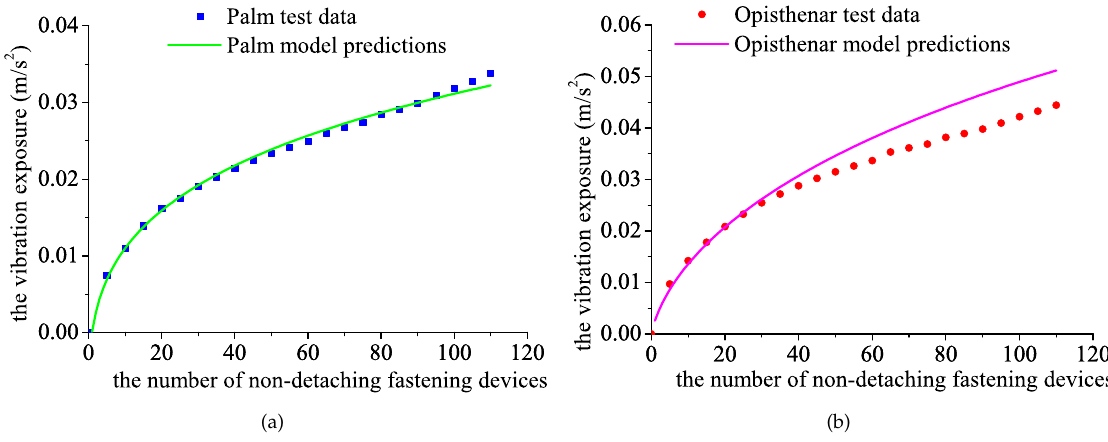
predicted by this model is larger than the actual value.